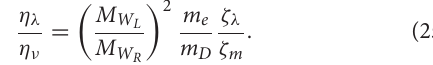
FIGURE 5 | The allowed range of values for the ratio η λ /η ν (in green) as a function of the mass of the heavy vector boson M W corresponds to the case of equal importance of both m ββ and λ mechanisms in the 0 νββ -decay rate.